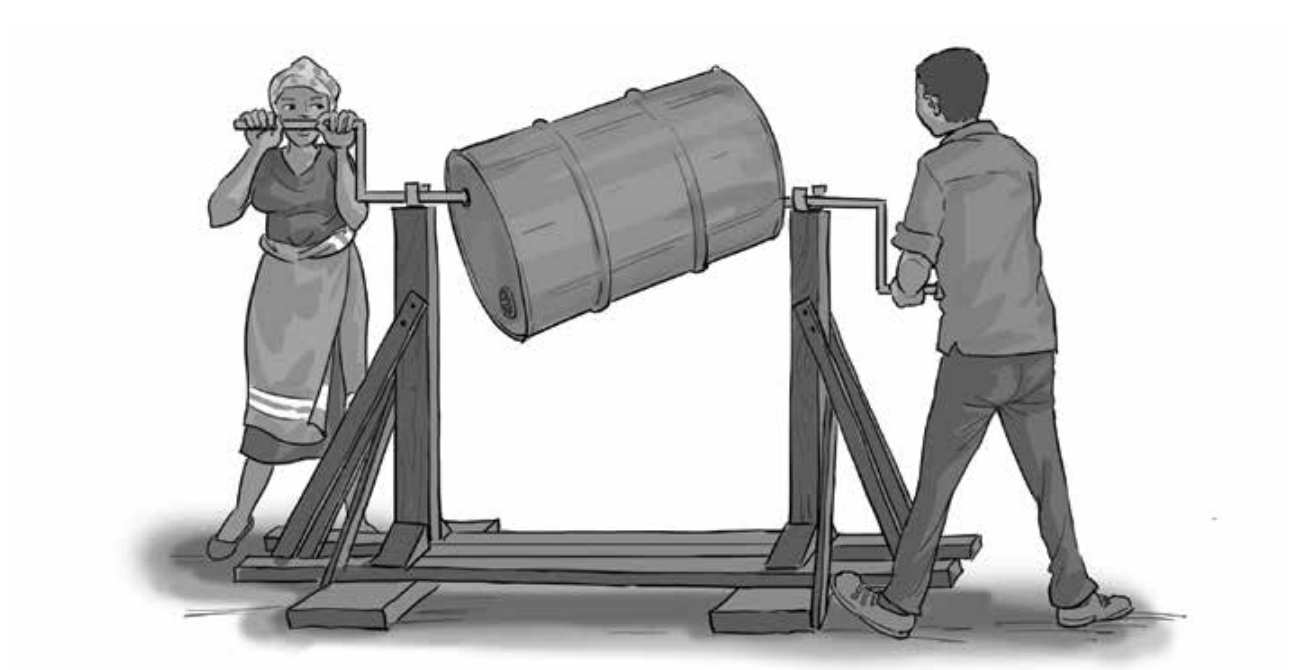
Figure 3: Simple hand-operated mixing drum for applying pesticides to